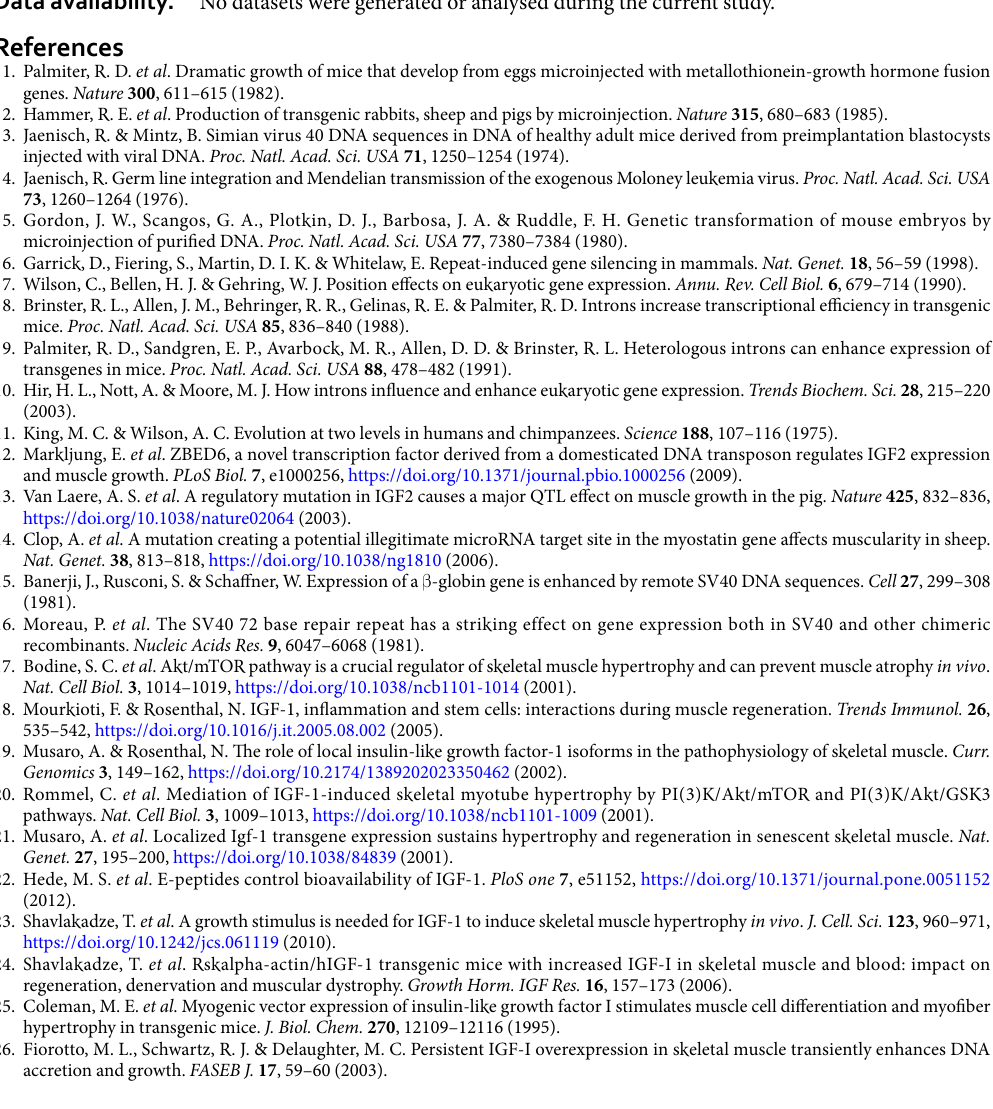
The relative expression levels of Igf1 mRNA in myotubes of single-cell colonies were displayed as fold changes relative to that in WT C2C12 myotubes using the 2 − △△ CT method. The relative expression levels of Igf1 mRNA in the gastrocnemius muscles were calculated using the 2 − △ CT